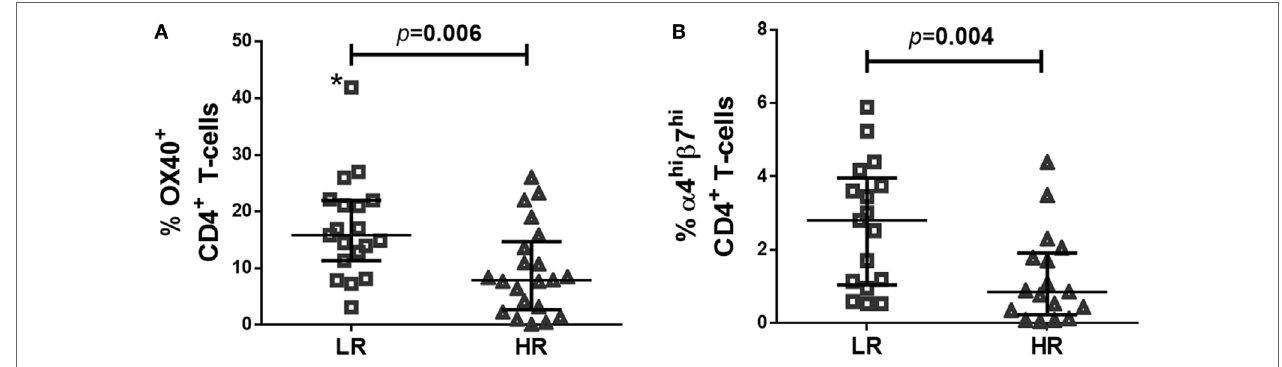
FigUre 1 | Expression of OX40 and α 4 β 7 in CD4 T-cells of LR-subjects at combined antiretroviral treatment onset. (a) Frequency of OX40 + CD4 + T-cells; (B) Frequency of α 4 hi β 7 hi CD4 + T-cells. After excluding outlier value (*) statistical significance was p = 0.009. Data were determined using multiparametric flow cytometry and are expressed as median value and interquartile range (IQR). Mann–Whitney test was used for the statistical significance